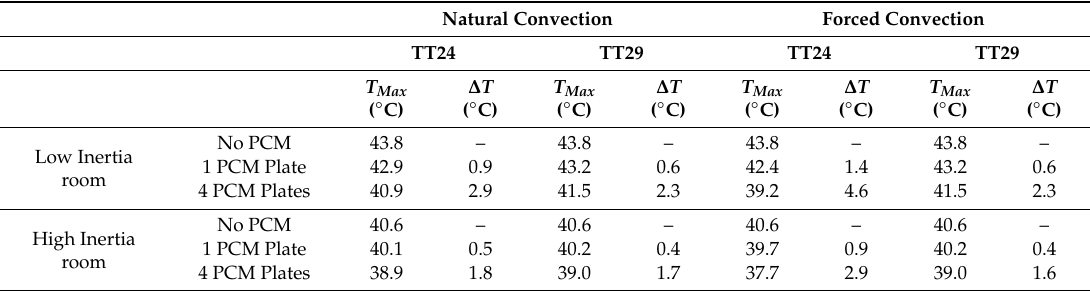
Figure 14. Indoor temperatures, for the low inertia case with forced convection at the place surfaces. Table 6. Impact of the PoDIT system upon indoor air temperature of the reference room, for several configurations and conditions, considering the weather under heat wave